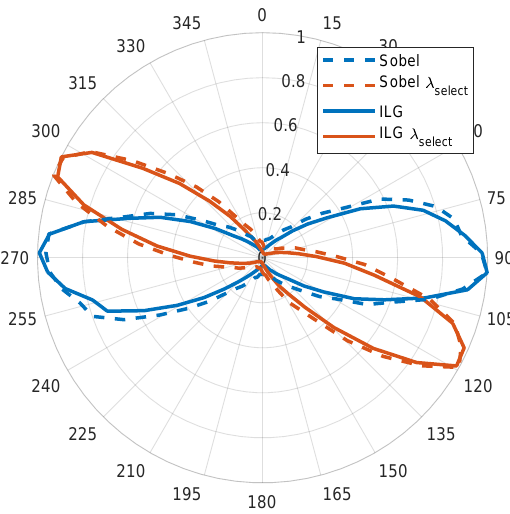
Figure 5. HOG for various level of processing.